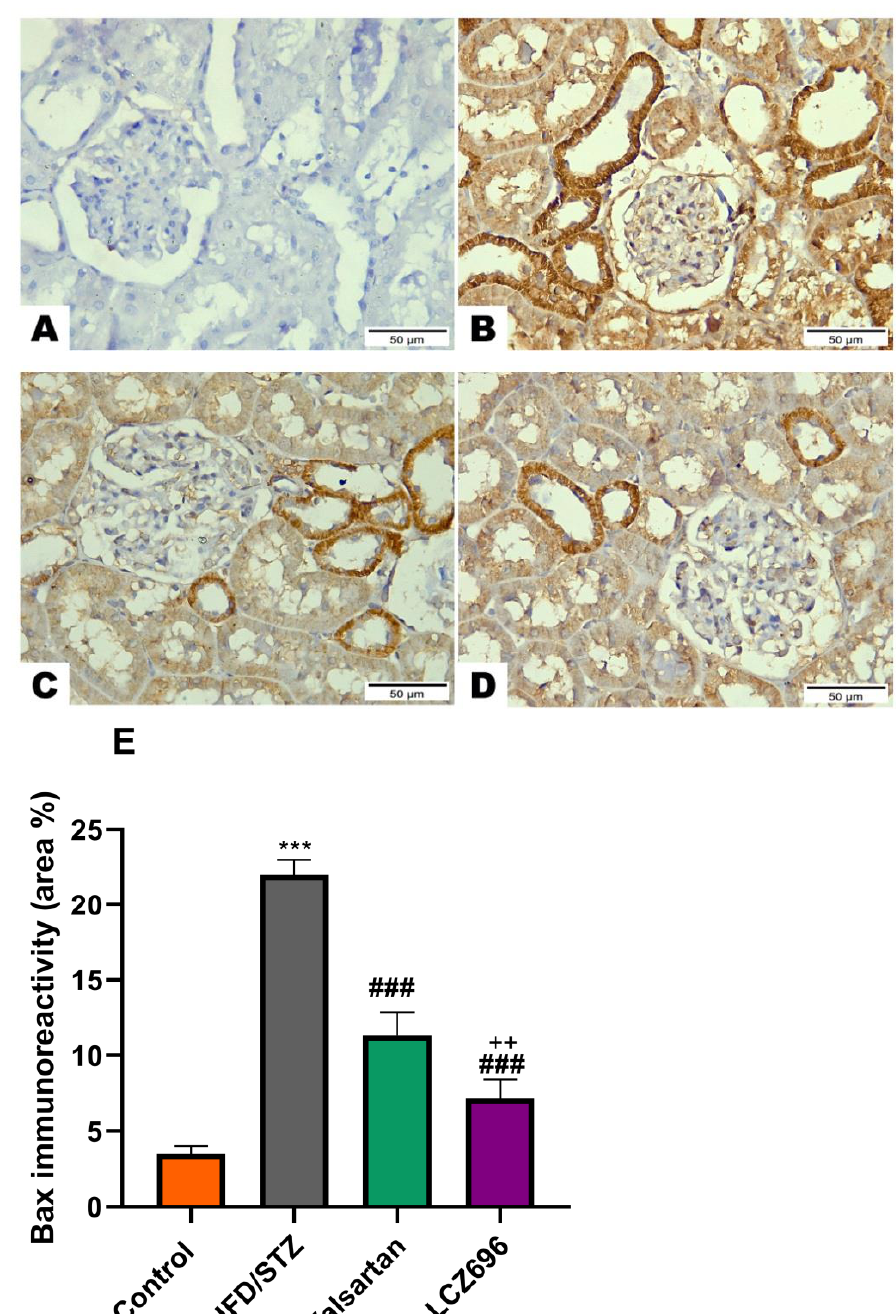
Figure 7. The effects of LCZ696 or valsartan on renal apoptosis marks in HFD/STZ-induced diabetic rats. A representative photomicrograph of renal cortex showing Bax immunohistochemistry protein distribution in different study groups. ( A ) control, ( B ) HFD/STZ, ( C ) valsartan-treated group, and ( D ) LCZ696- treated group. Area percent of immunoreactivity of Bax were quantified ( E ), ( n = 3); data are presented as mean ± SEM, *** p < 0.001 versus control; ### p < 0.001 versus HFD/STZ; ++ p < 0.01 versus valsartan (scale bar 50 µm).